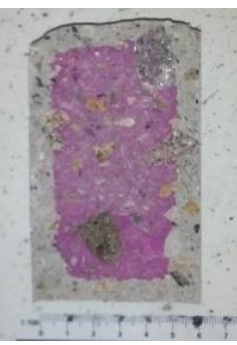
Figure 10. Concrete mixture after being sprayed with phenolphthalein.